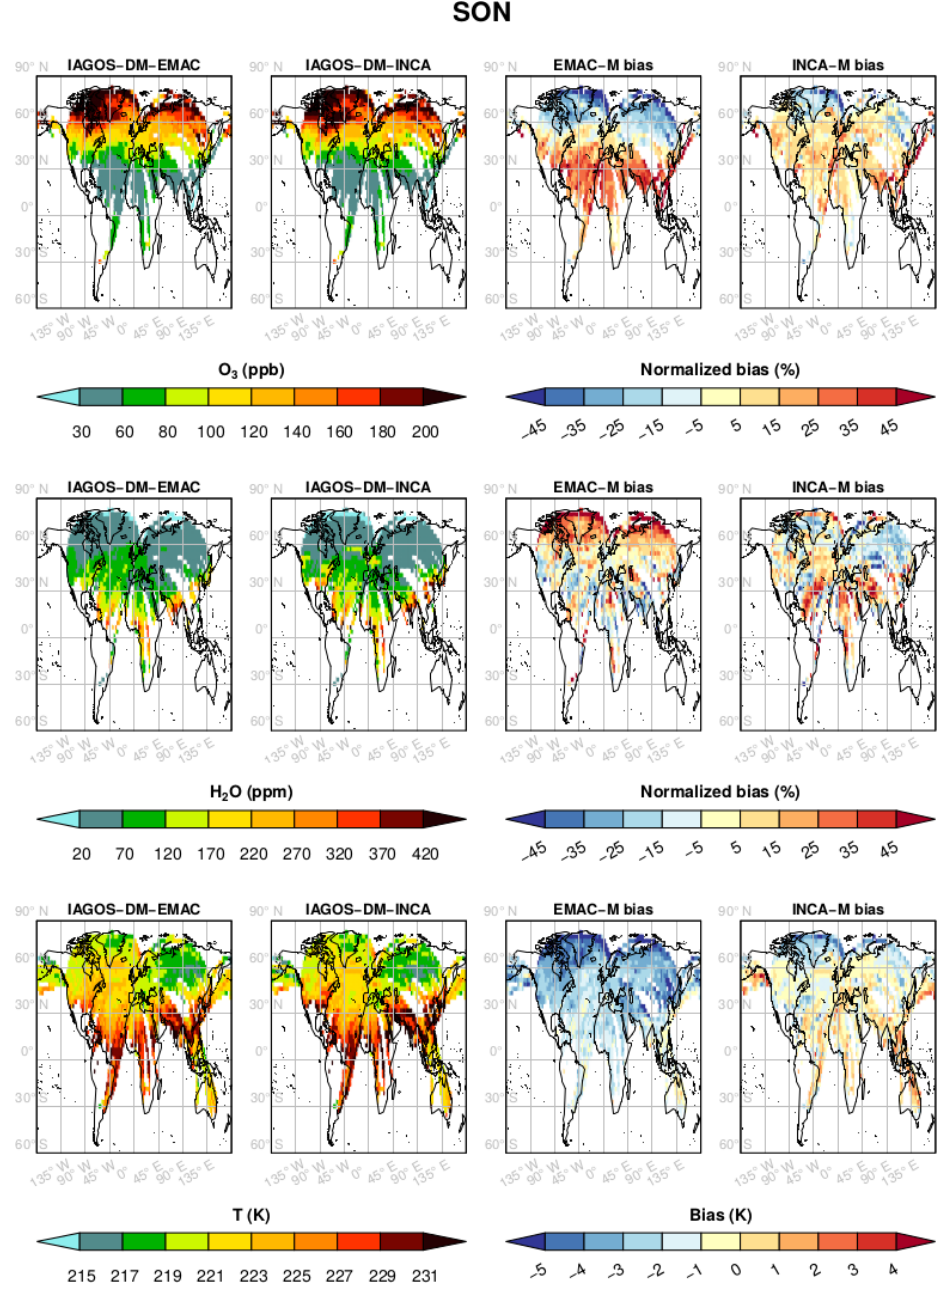
Figure A12. Same as Fig. A8 for boreal